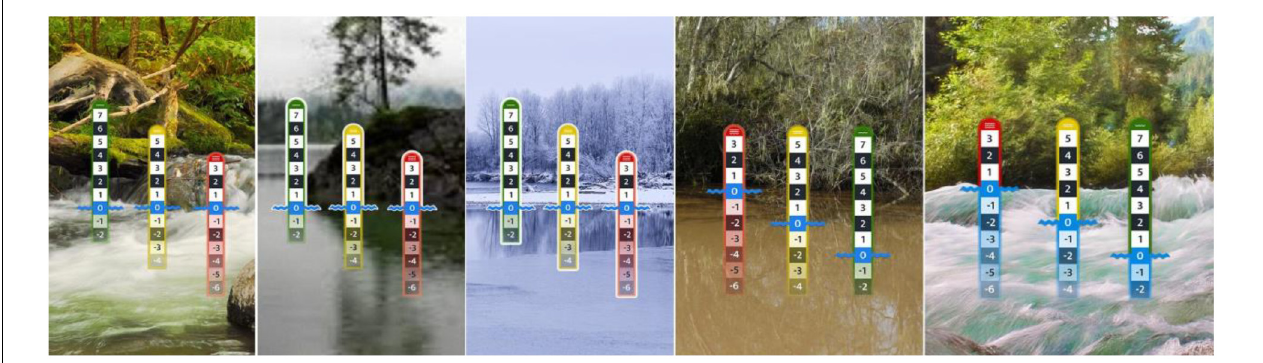
FIGURE 8 | Staff gauge design variants in different environments. Design/author: Philipp Hummer, SPOTTERON Citizen Science, www.spotteron.net. Note that the virtual staff gauges were not scaled nor placed correctly (see Figure 1 ).